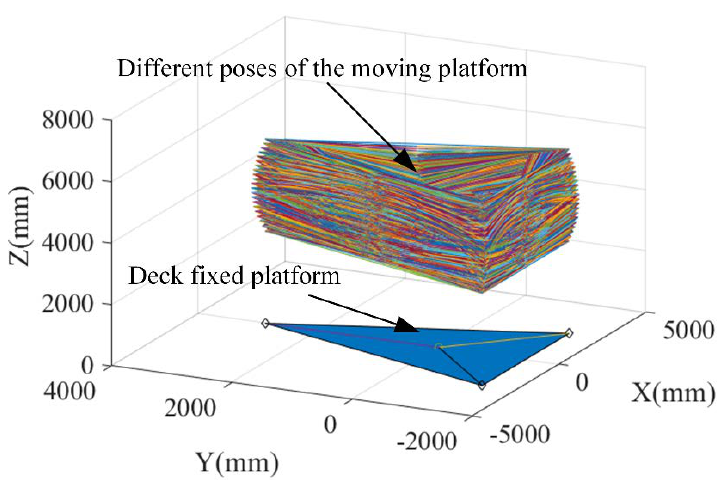
Figure 3. 3-RPS parallel compensate platform motion space.